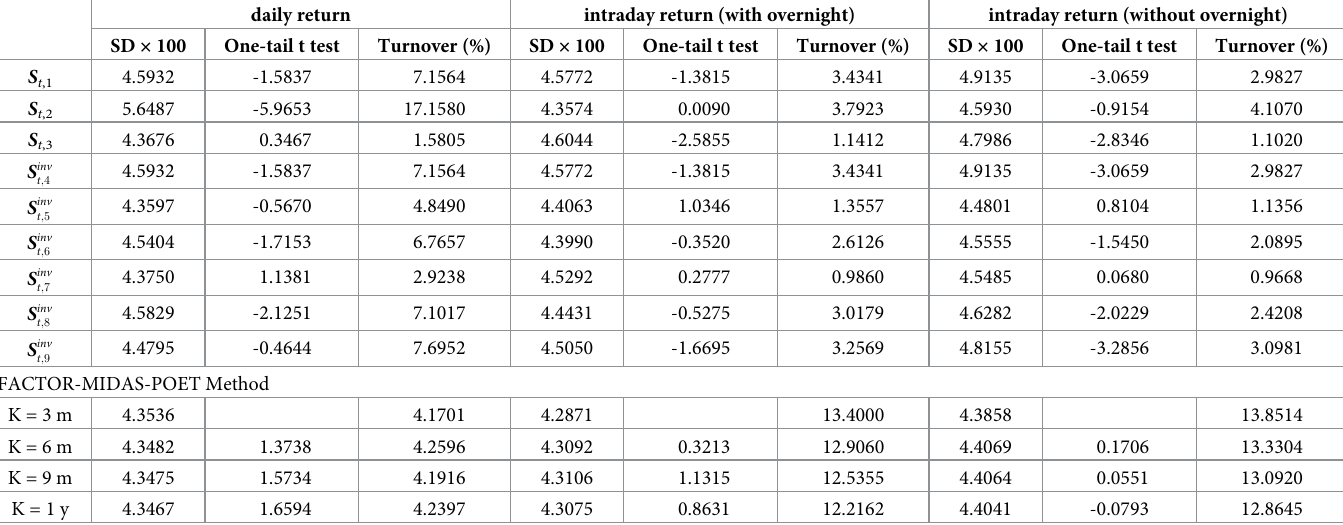
Table 9. Out-of-sample performances of portfolios with T = 6